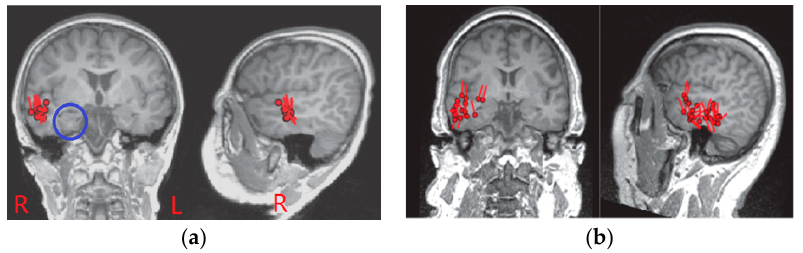
Figure 6. Magnetic source imaging results based on the SPS method based on all spikes. ( a ) Localization results for the first patient displayed on individual MRI from coronal and sagittal views, wherein the hippocampal region was denoted by a blue circle on coronal view, and the red mark “R” (or “L”) denoted the right (or left) side of the brain; ( b ) Localization results for the second patient displayed on individual MRI from coronal and sagittal views.